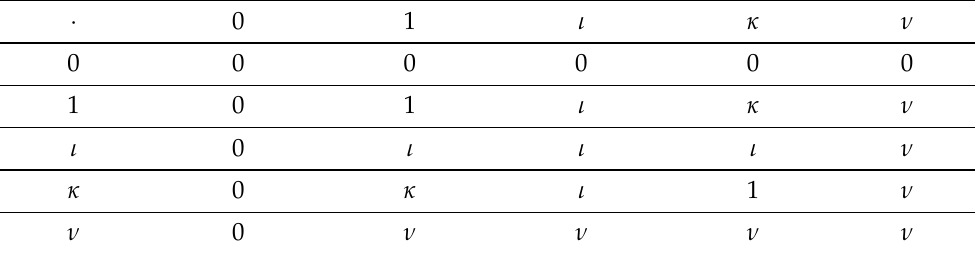
Table 3. Table of binary multiplication. ( S = { 0,1, ι , κ , ν }